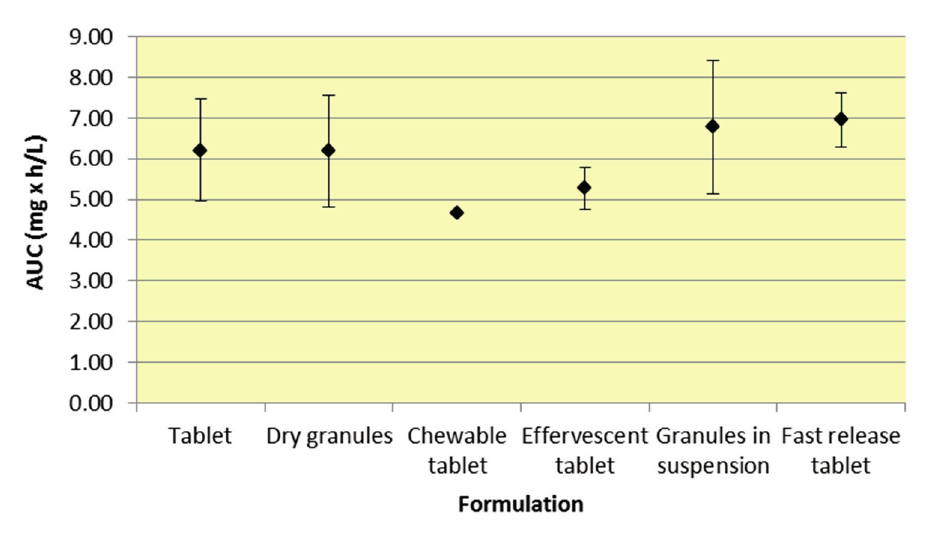
Figure 1. Summary ASA AUC for various 500 mg formulations (Mean ± SD).